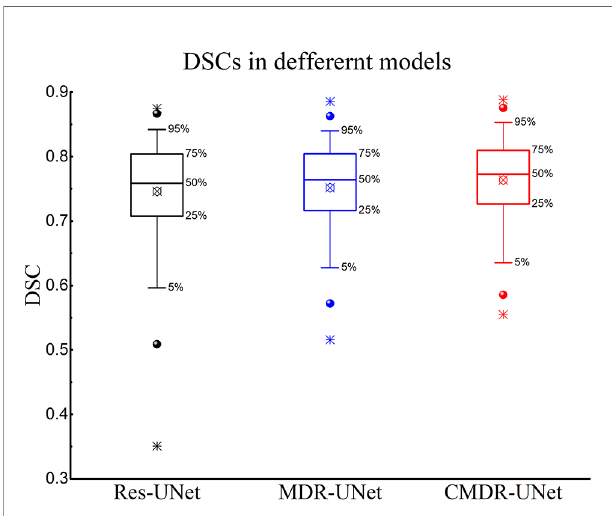
FIGURE 4 | Boxplot showing the DSCs of different models. The symbols represents the means, represents the 1% and 99%, represents the min and